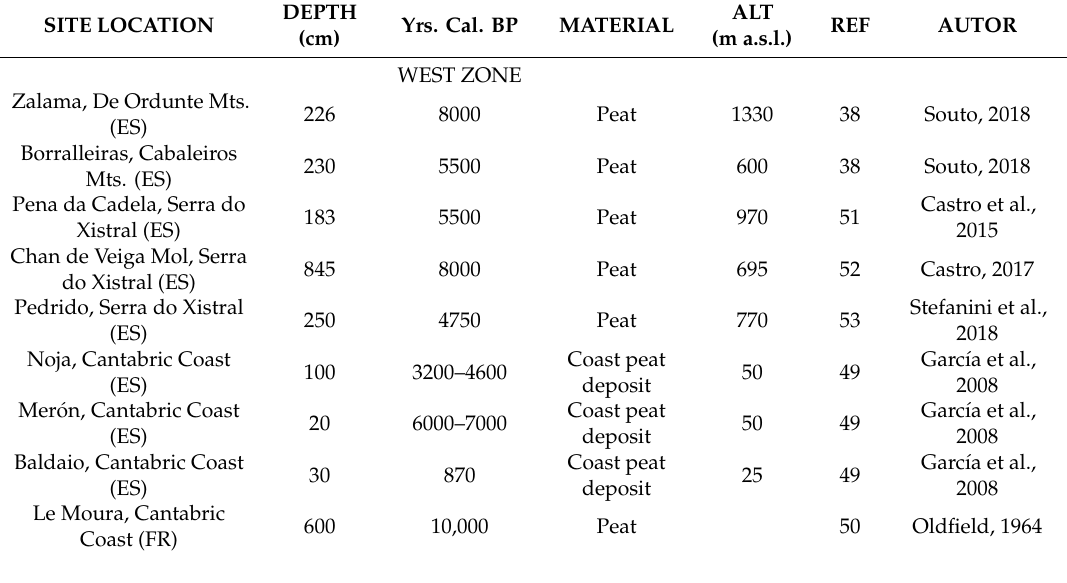
Zalama, De Ordunte